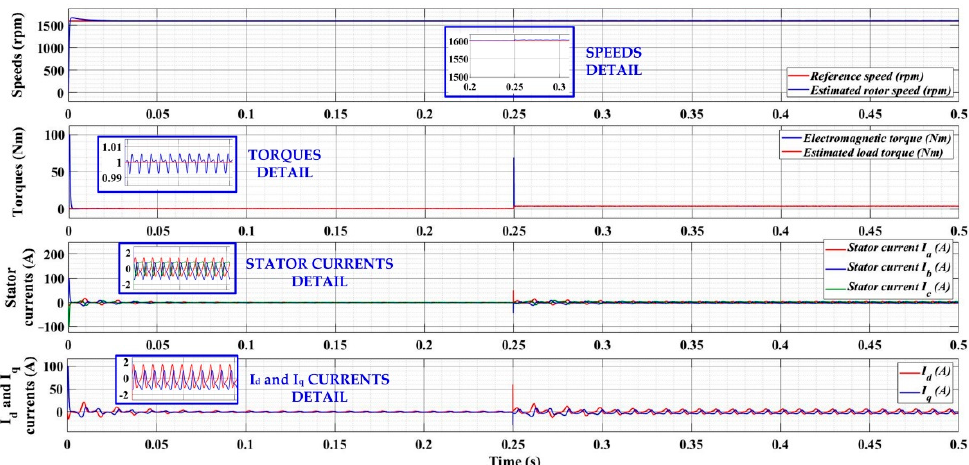
Figure 17. Time evolution for the numerical simulation of the PMSM control system based on the backstepping controller: ω ref = 1600 rpm, T L = 1 Nm → 4 Nm, K ω = 0.01, K I ω = 139, K q = 2900, K Iq = 150, γ = 0.01, K d = 100, and K id = 900.